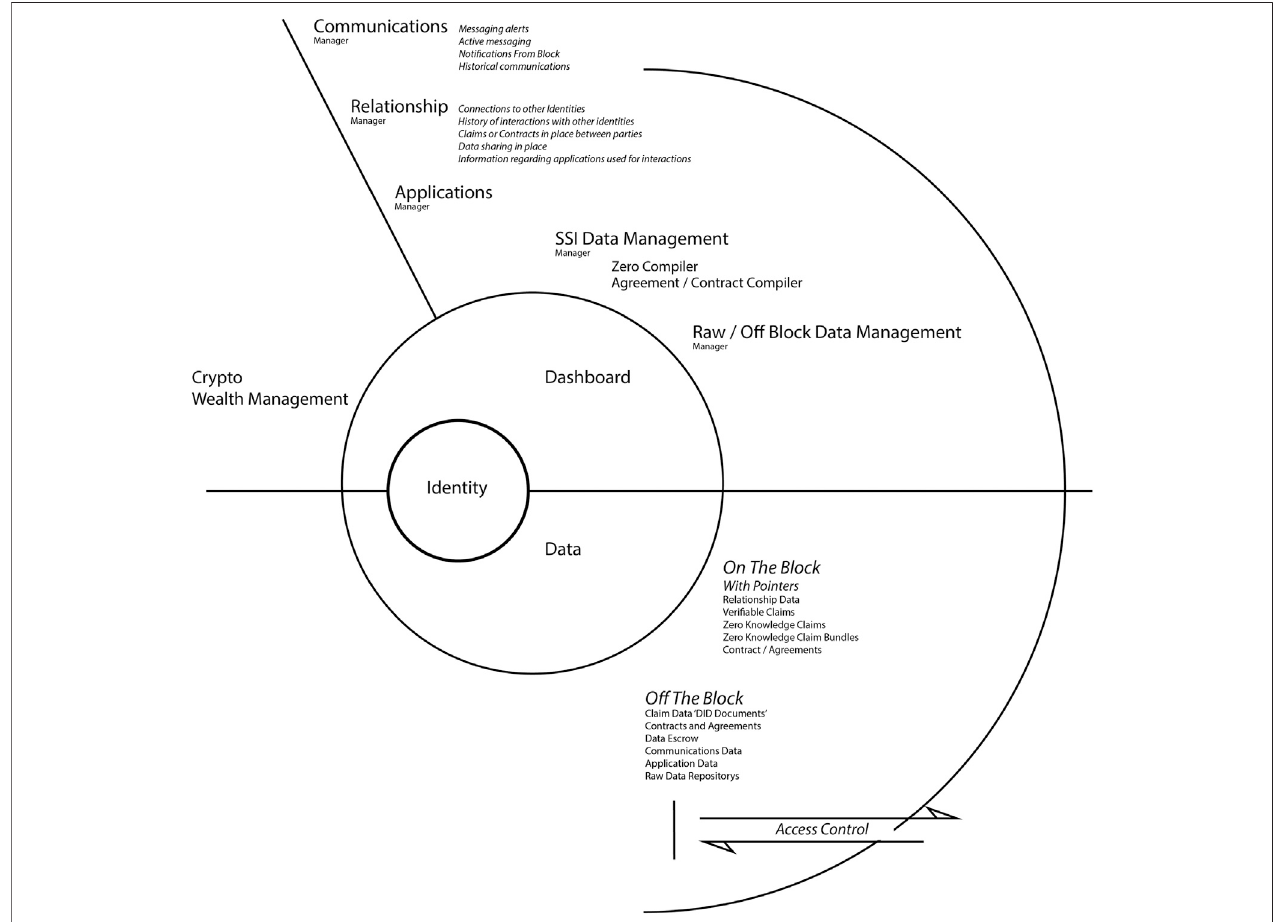
FIGURE 1 | The component parts of a sovereign boundary